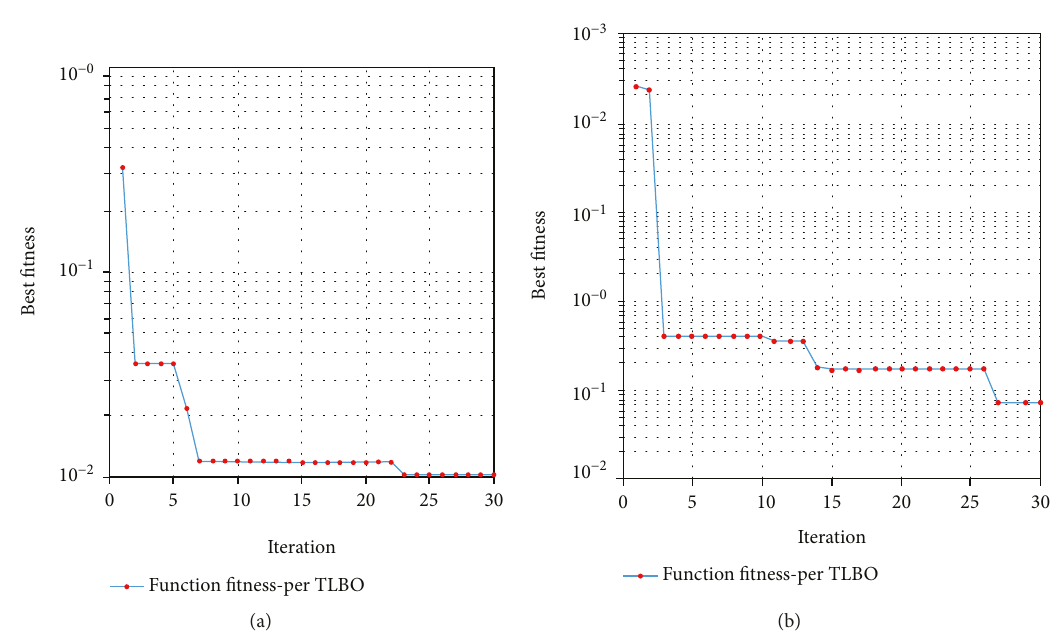
Figure 9: Convergence of the fi tness function of the inner loop i